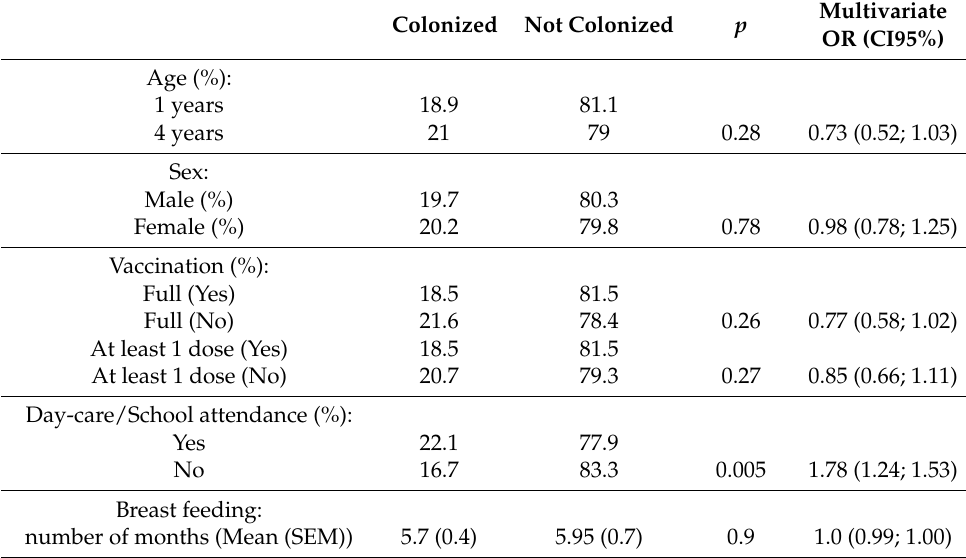
Table 2. Multivariate